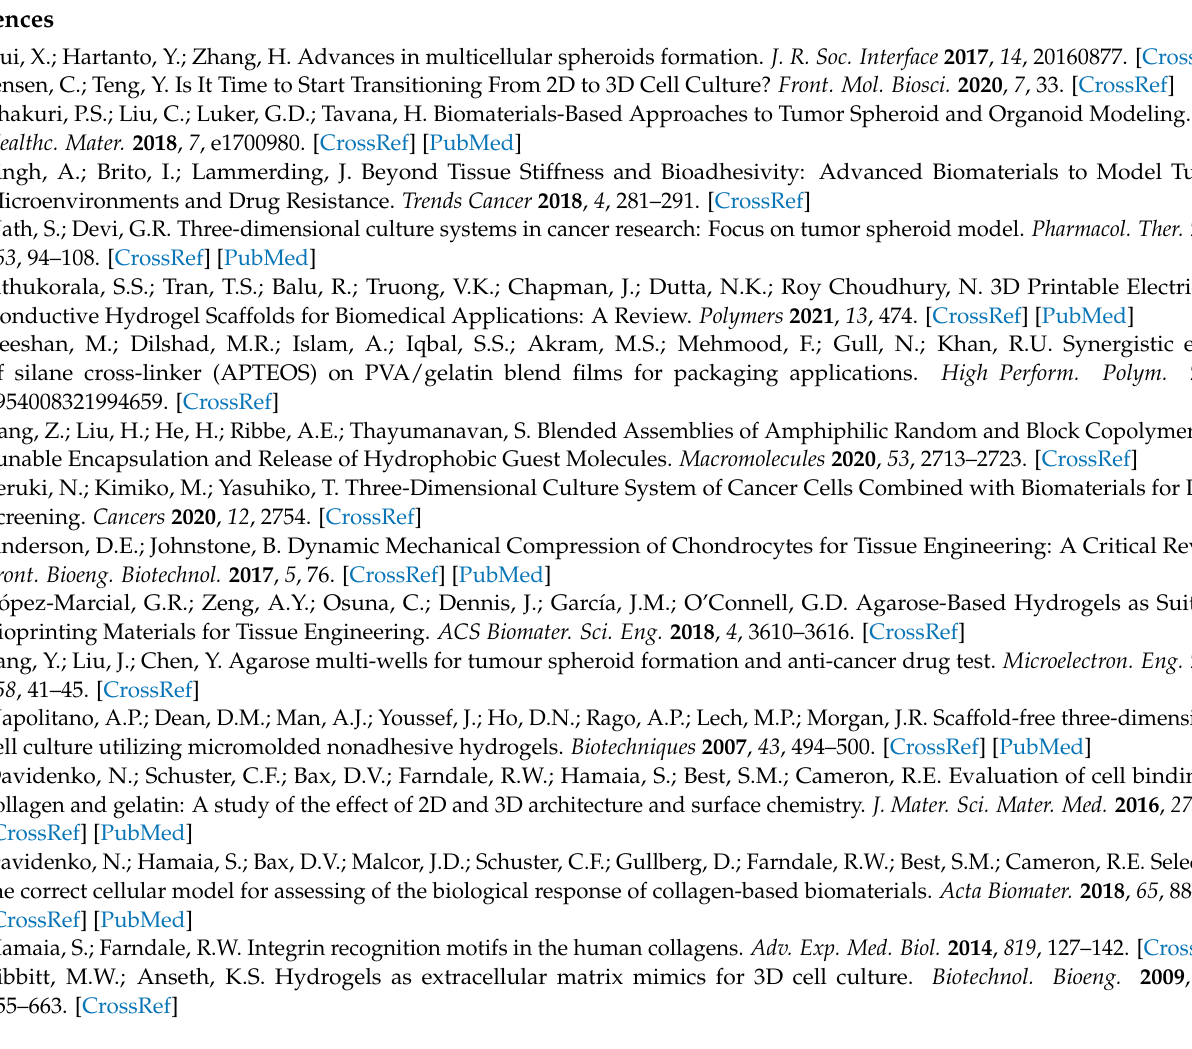
treatment, Figure S12: a–d) TEM images of MCF-7 spheroids grown for 8 days in the 0.125–0.02% A-C hydrogel, Figure S13: optical images of SH-SY5Y spheroids grown in the 0.125–0.02% and 0.25–0.02% A-C hydrogels up to 14 and 6 days, respectively, Figure S14: sketch depicting the effects over time of the hydrogel stiffness on the size and viability of breast tumor spheroids derived from MCF-7 and MDA-MB-361